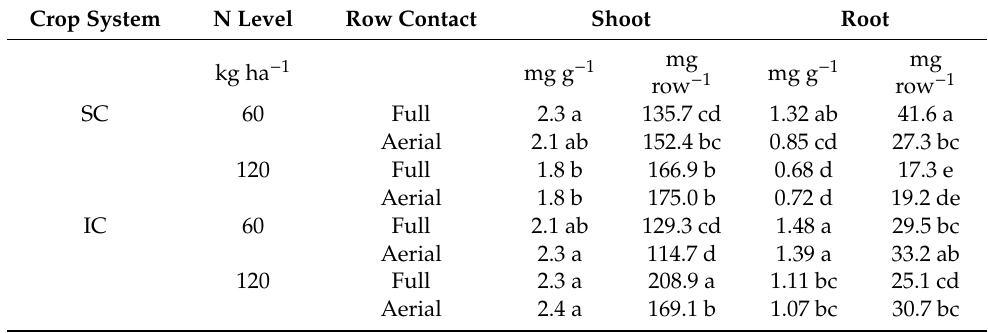
Table 10. Phosphorus concentration and content in the shoots and roots of triticale, as a ff ected by the Crop system × N level × Row contact interaction. SC, sole crop; IC, intercrop. For each parameter, values followed by the same letter within a column are not significantly di ff erent at P < 0.05, Tukey’s